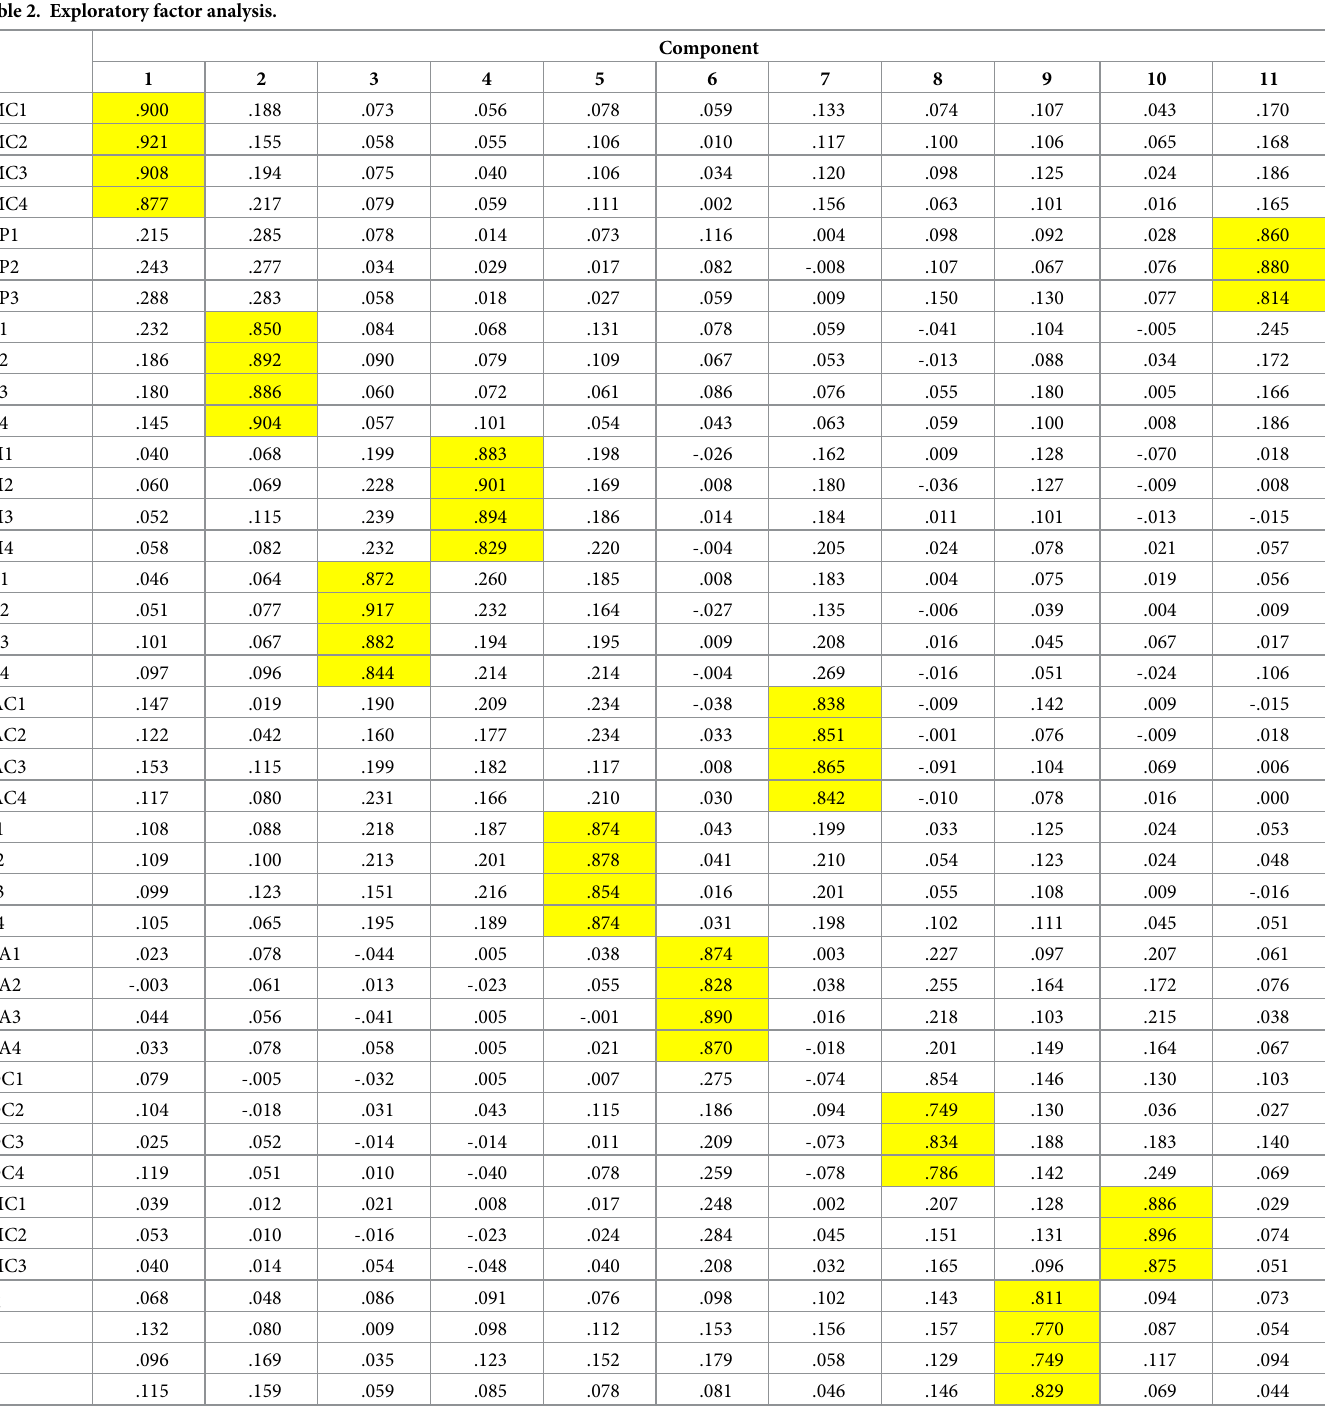
Table 2. Exploratory factor